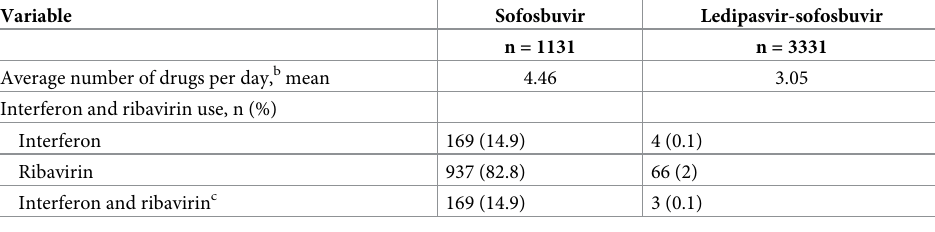
Table 2. Drugs taken while on treatment for sofosbuvir and ledipasvir-sofosbuvir a . Variable Sofosbuvir Ledipasvir-sofosbuvir n = 1131 n = 3331 Average number of drugs per day, b mean 4.46 Interferon and ribavirin use, n (%) Interferon 169 (14.9) Ribavirin Interferon and ribavirin c 169 (14.9) 3